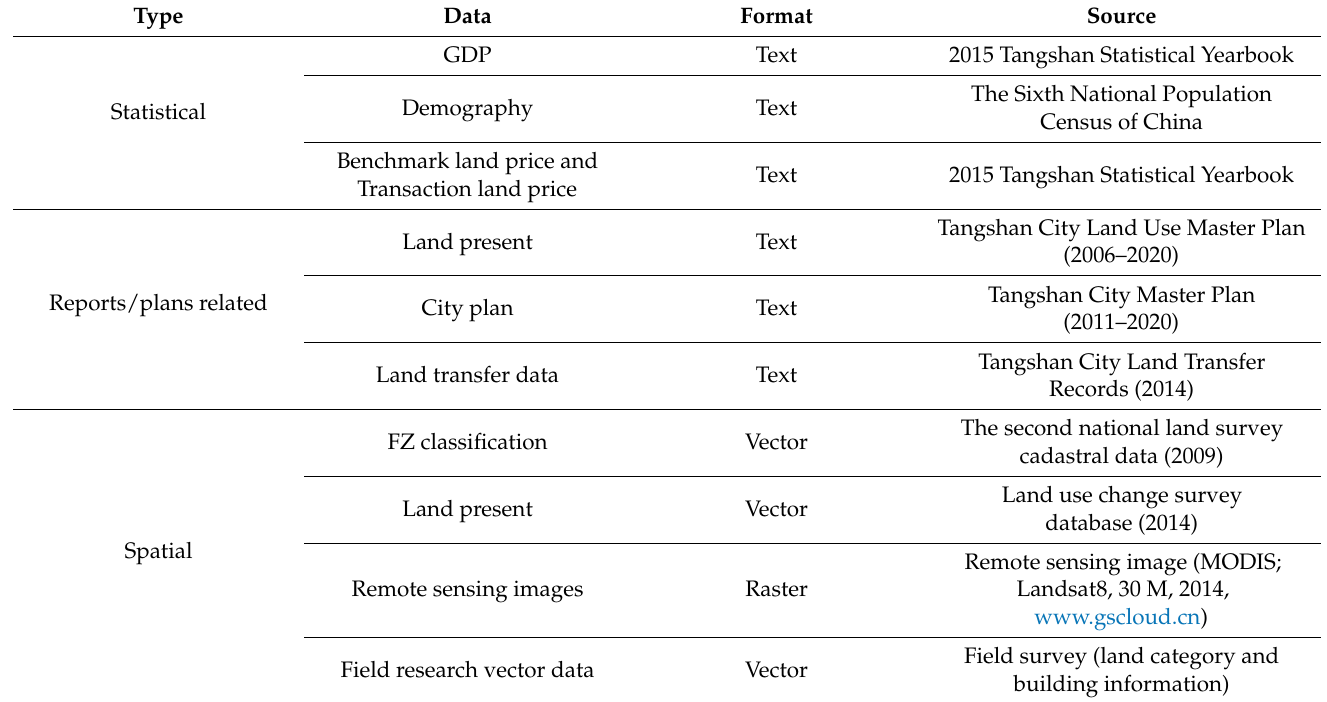
Table 1. Data resources and